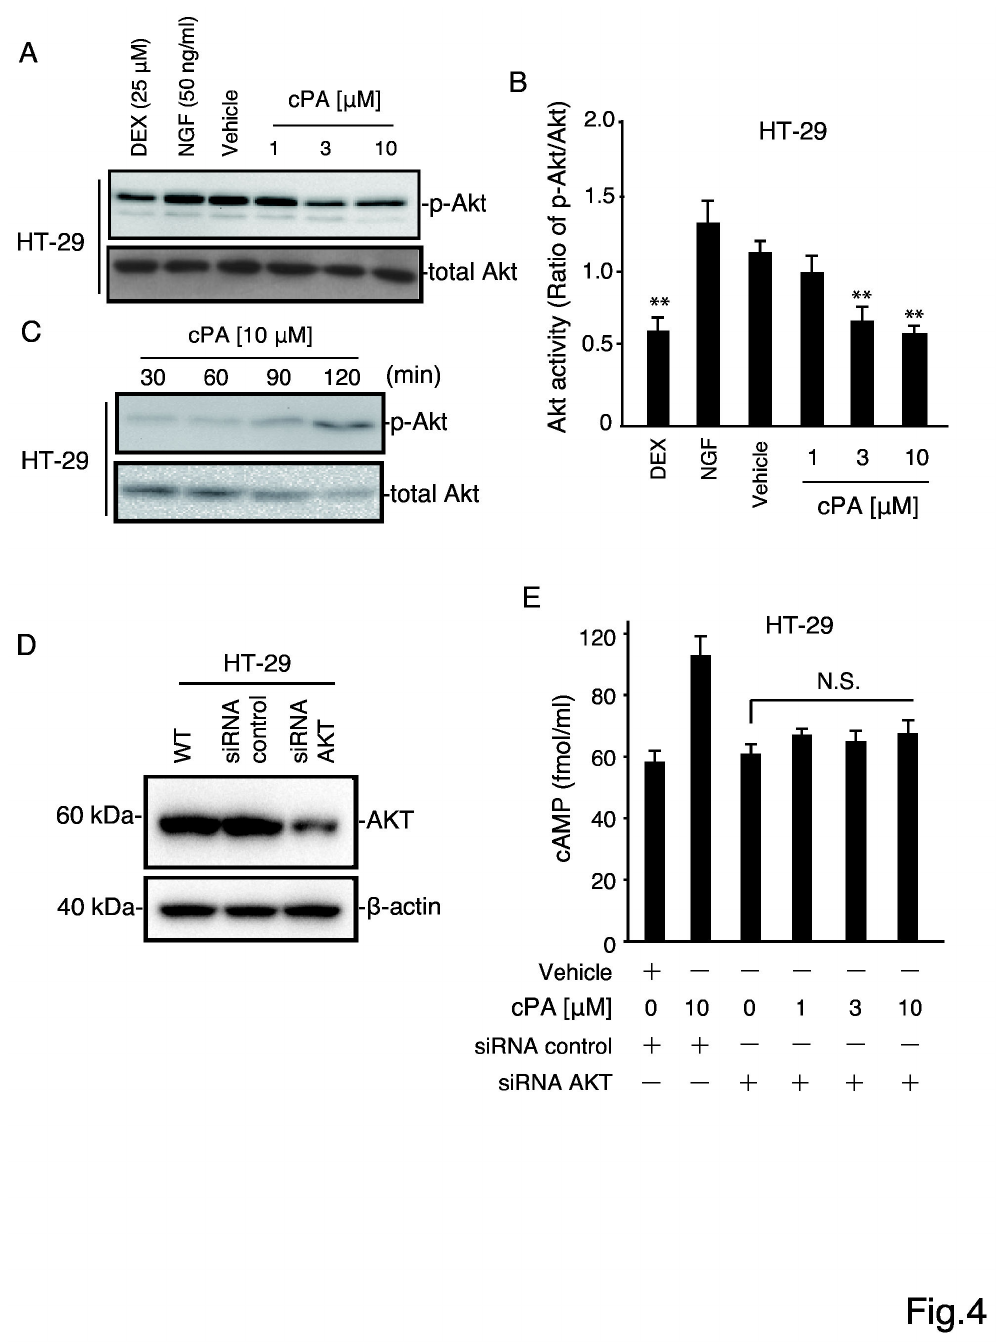
Figure 4. Inhibition of Akt phosphorylation in HT-29 cells by cPA. (A) Akt phosphorylation in HT-29 cells treated with cPA (1, 3, and 10 μM), NGF (50 ng/mL, positive control), or dexamethasone (Akt inhibitor, 25 μM). Phosphorylated Akt (p-Akt) and total Akt were detected by immunoblotting. (B) The intensities of the Akt bands were quantified, and the ratio of phosphorylated to total Akt was calculated. Data are expressed as means ± SEM (n = 3), **p < 0.01. (C) HT-29 cells were treated with cPA (10 μM) and lysates were collected at 30, 60, 90, and 120 min. Akt inhibition was measured as a loss of Ser473 phosphorylation. (D) Knocking down Akt expression in HT-29 cells. Total protein was extracted from untransfected cells and from cells transfected with control siRNA or Akt- specific siRNA and analyzed by western blotting with an anti-Akt antibody; β-actin was stained as a protein-loading control. (E) Intracellular cAMP levels in HT-29 treated with 1, 3, or 10 μM cPA for 60 min after Akt knockdown; cAMP levels were determined in cell lysates using the cAMP Biotrak Enzyme immunoassay system. Data are expressed as means ± SEM (n = 3), **p < 0.01. doi: 10.1371/journal.pone.0081139.g004 PLOS ONE |